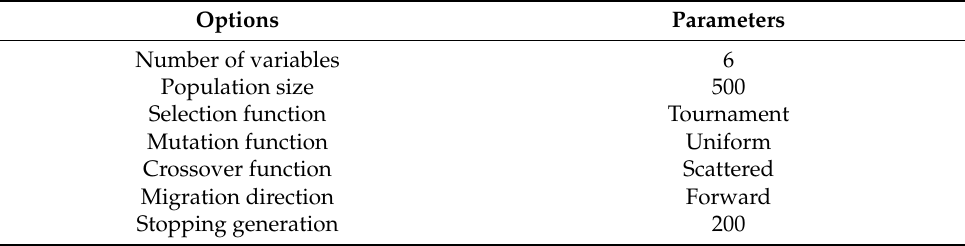
Table 5. Specific parameter settings of NSGA-II.